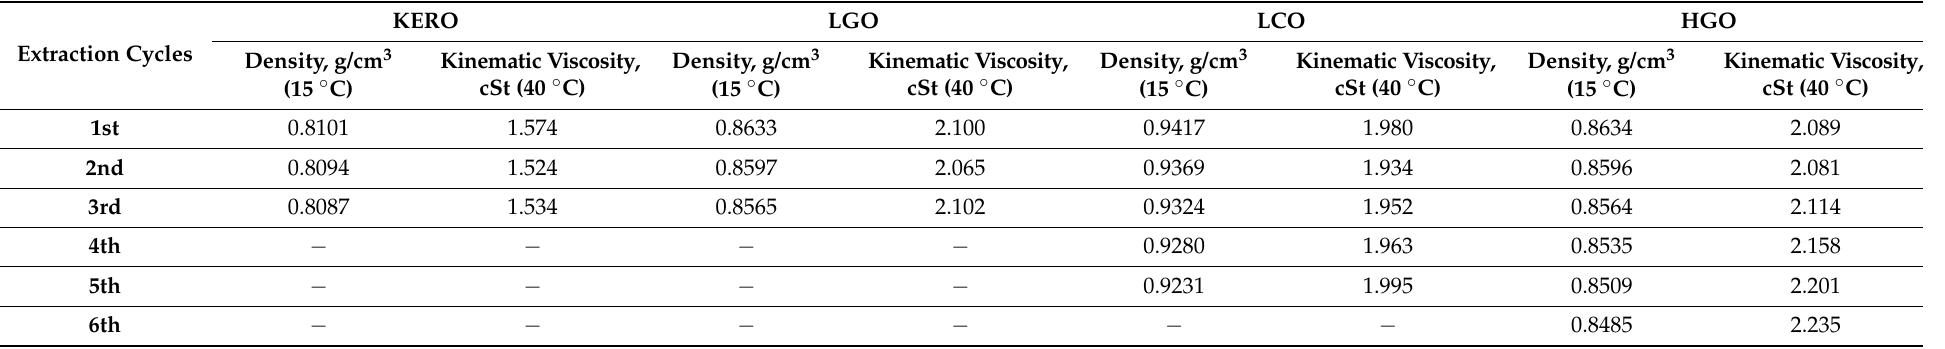
Table 13. Density and kinematic viscosity of the surrogate raffinates during the multiple-stage extractions with recycled [BMIM][HSO 4 ].